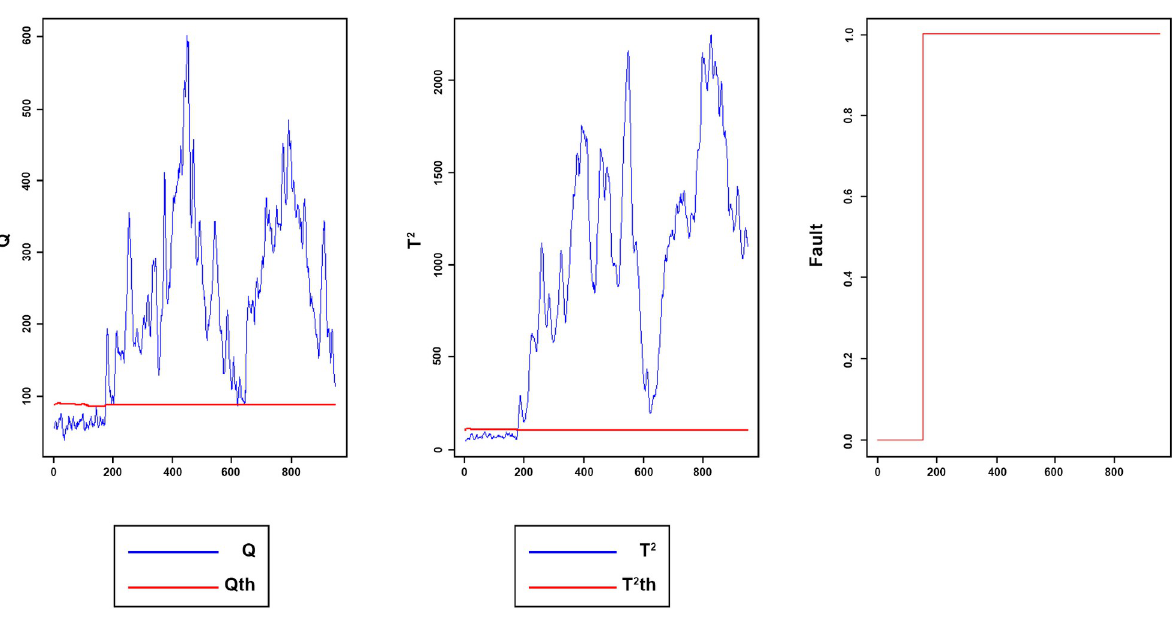
Fig 11. Monitoring performance of MWDPCA for fault 8.